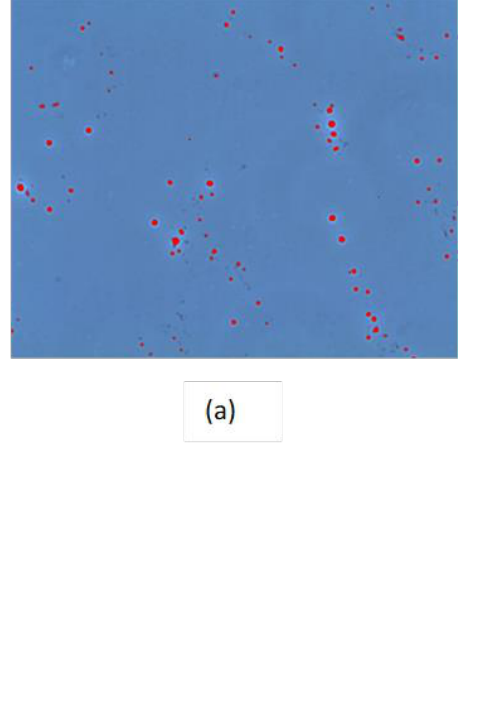
Figure A3. Image examples of emulsions in 3.5% NaCl solution ( a ) sample after 0.5 h, ( b ) sample after 2.5 h, ( c ) sample after experiment at 24 h. (a)